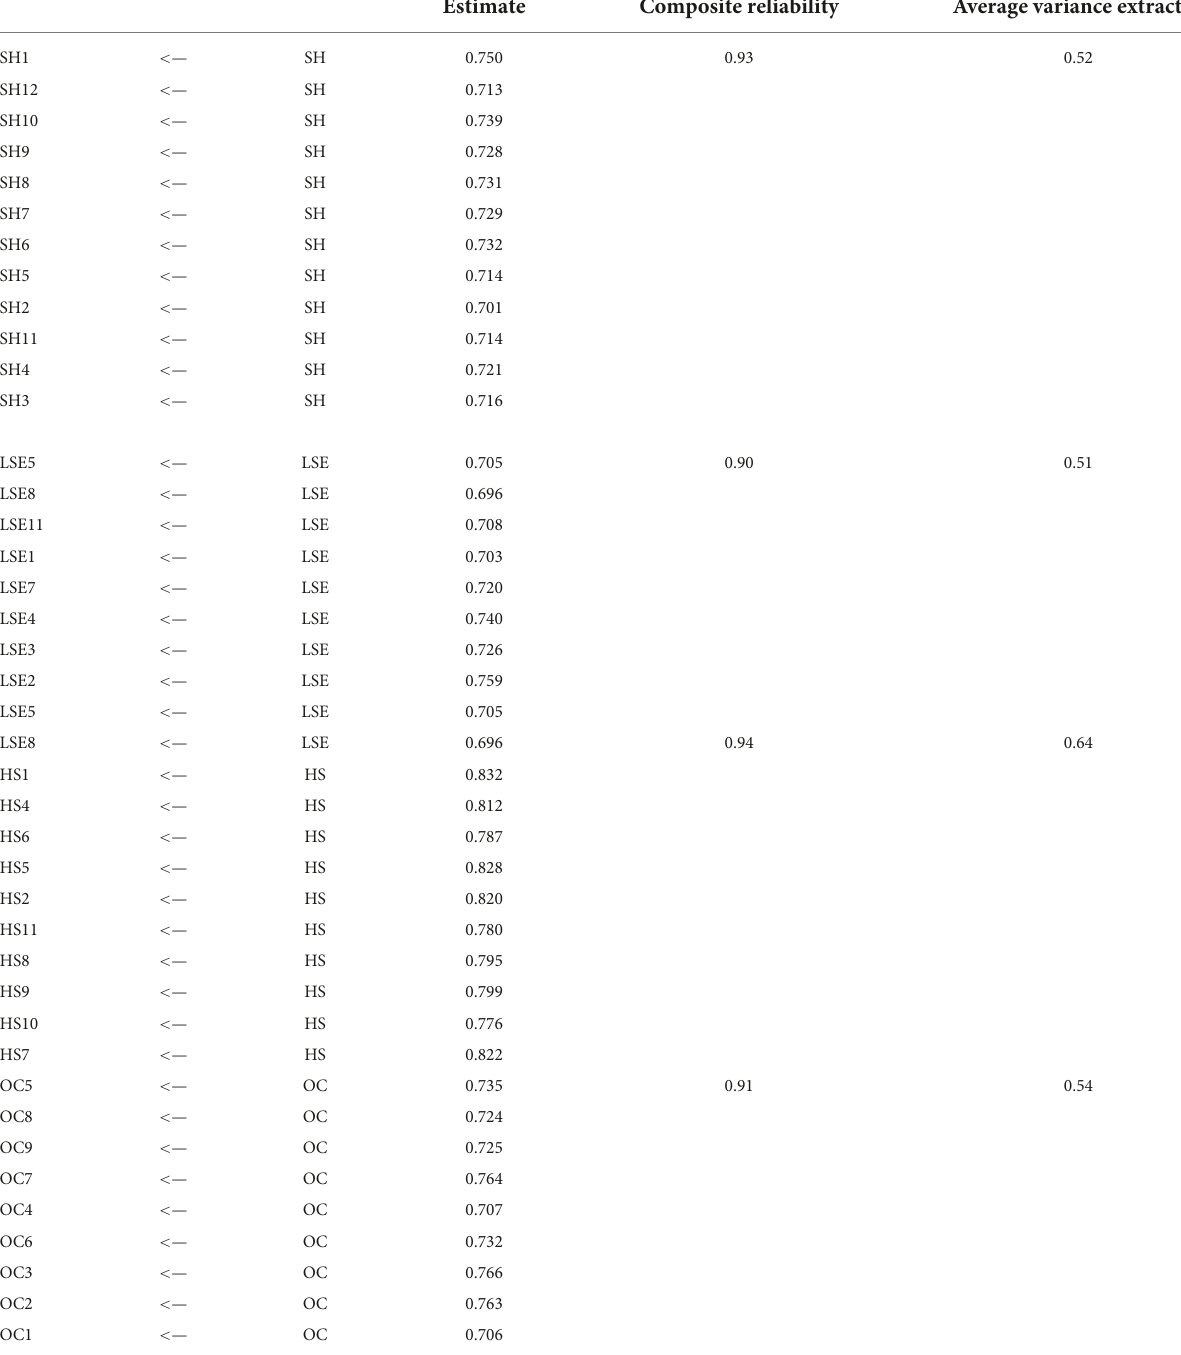
TABLE 1A Standardized factor loadings, composite reliability and average variance extracted of four factors model. Estimate Composite reliability Average variance extracted